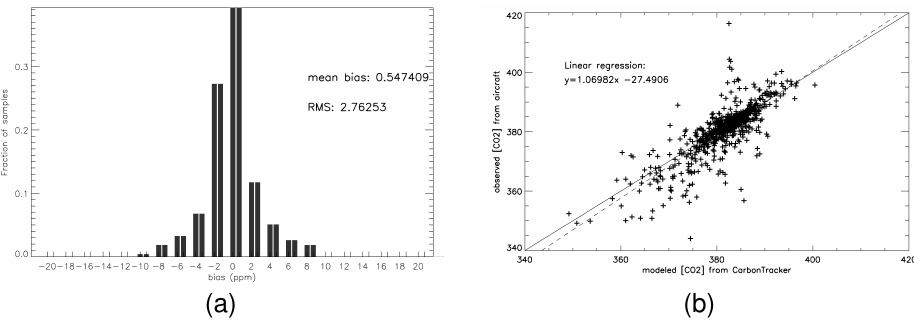
Fig. 6. Histogram of the model-data mismatch at the boundaries with the mean and standard deviation used to correct for the mean bias and to define uncertainties related to the boundaries in the inversion (on the left) and the linear regression between observed aircraft and CT v 09 modeled CO 2 mixing ratios (on the right).